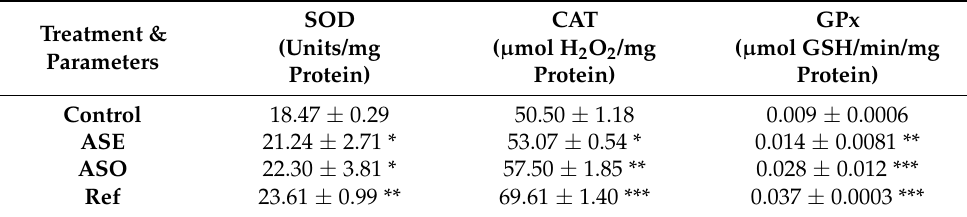
Table 3. Effects of Allium subhirsutum L. extract (ASE), Allium subhirsutum L. oil and the reference drug “Cytolcentella ® ” on enzymatic antioxidant profile of granulation tissue by estimation of SOD, CAT and GPx activities.